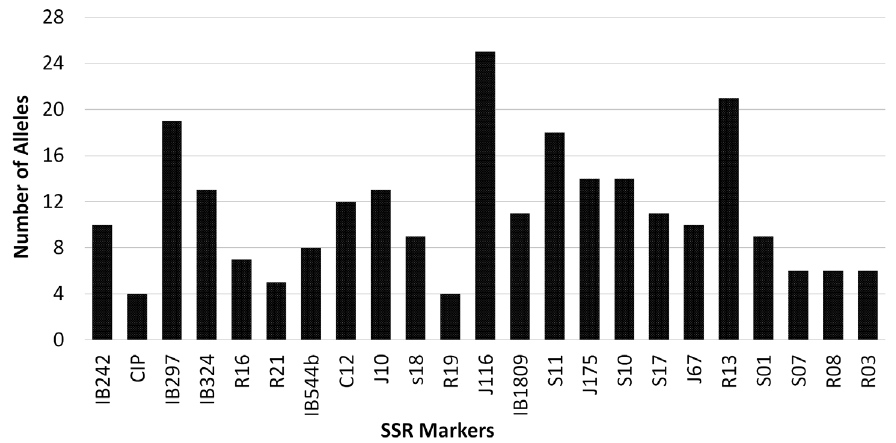
Fig. 1. Distribution of the number of alleles per locus analyzed for 23 SSR loci in 167 accessions of sweet potato ( Ipomoea batatas ).